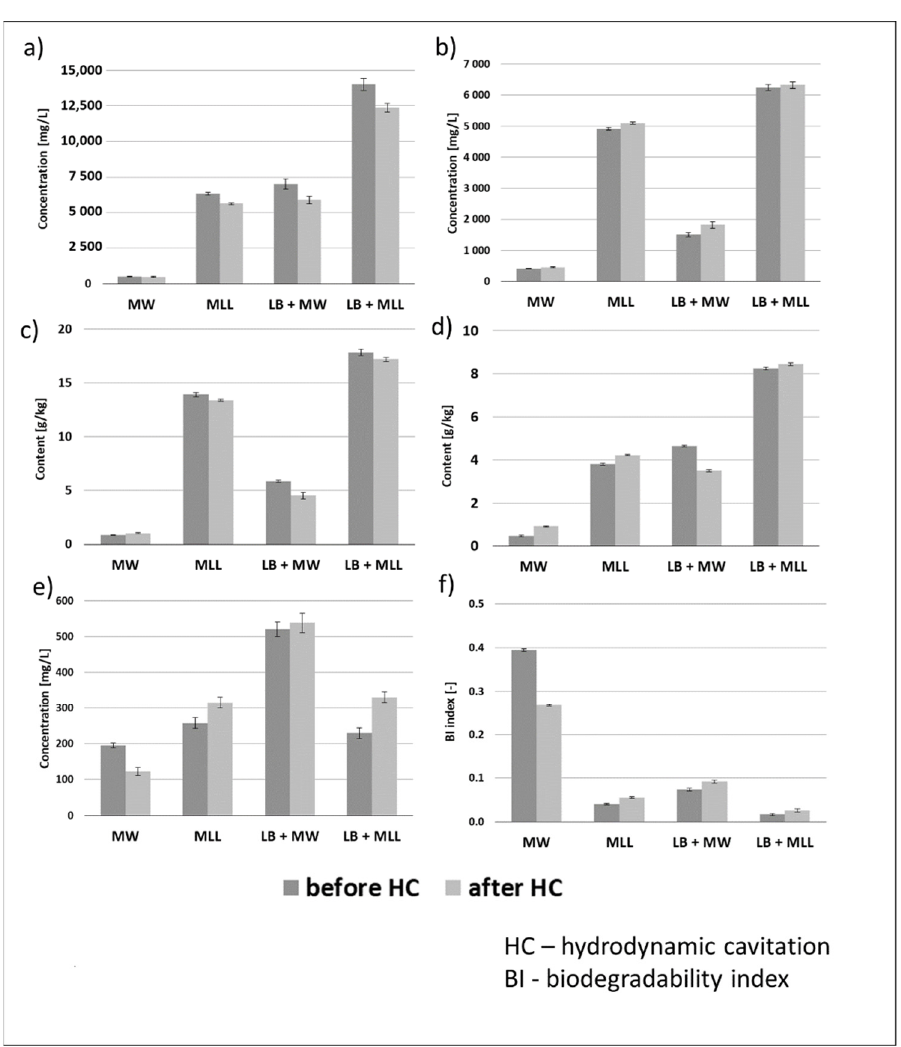
Figure 3. Mixture composition before and after cavitation: ( a ) COD; ( b ) SCOD; ( c ) TS; ( d ) VS; ( e ) BOD5; and ( f ) BI (average values and standard deviations are given).